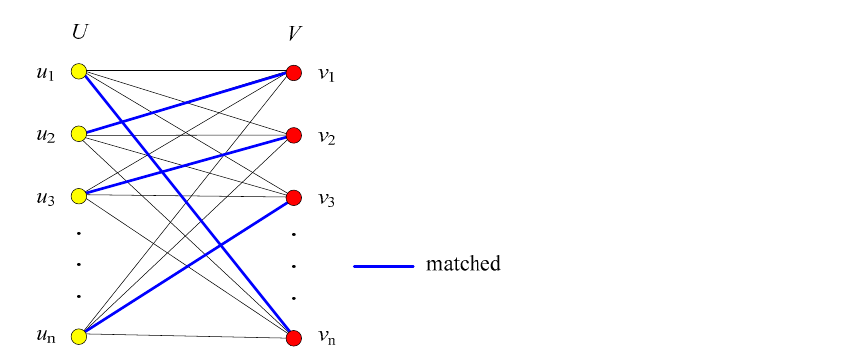
Figure 2. Complete bipartite graph and matching diagram.